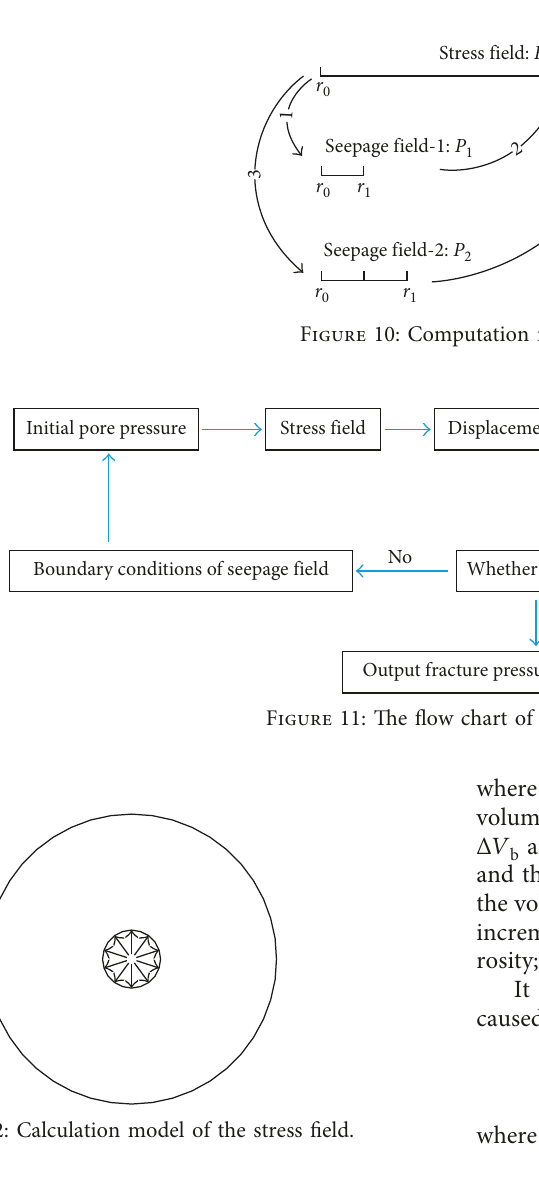
Figure 9: Failure patterns after (a) the water fracturing and (b) the nitrogen gas fracturing.